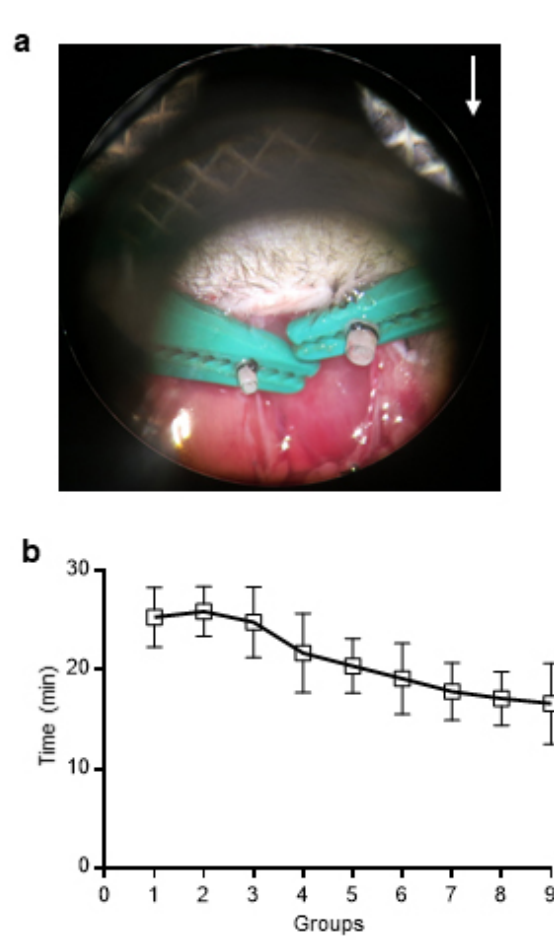
Fig. 4 - Vessel eversion can be successfully performed in a short time. (A) Both EJV and CA of the recipient mouse were everted. (B) The vessel preparation time was short. White arrow points toward the head of the recipient